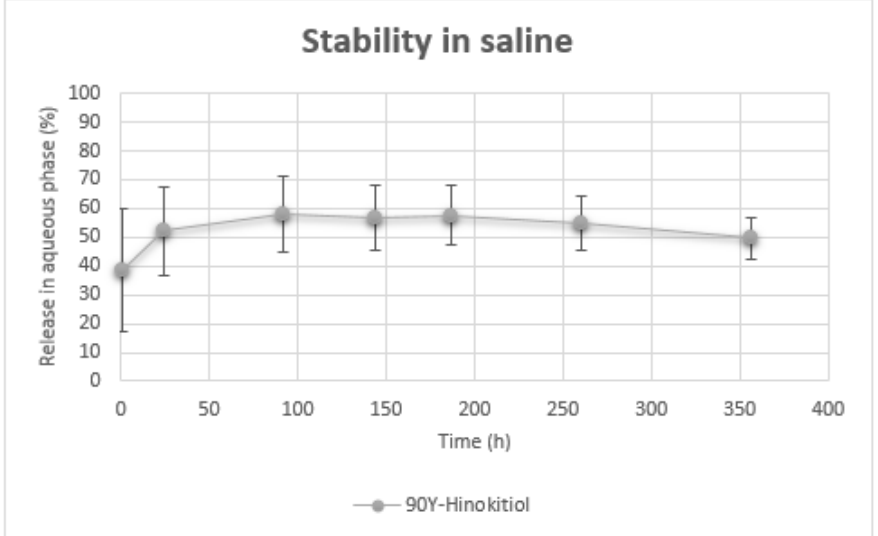
Figure 7. R elease of 90 Y in aqueous phase over time. Figure 7. Release of 90 Y in aqueous phase over